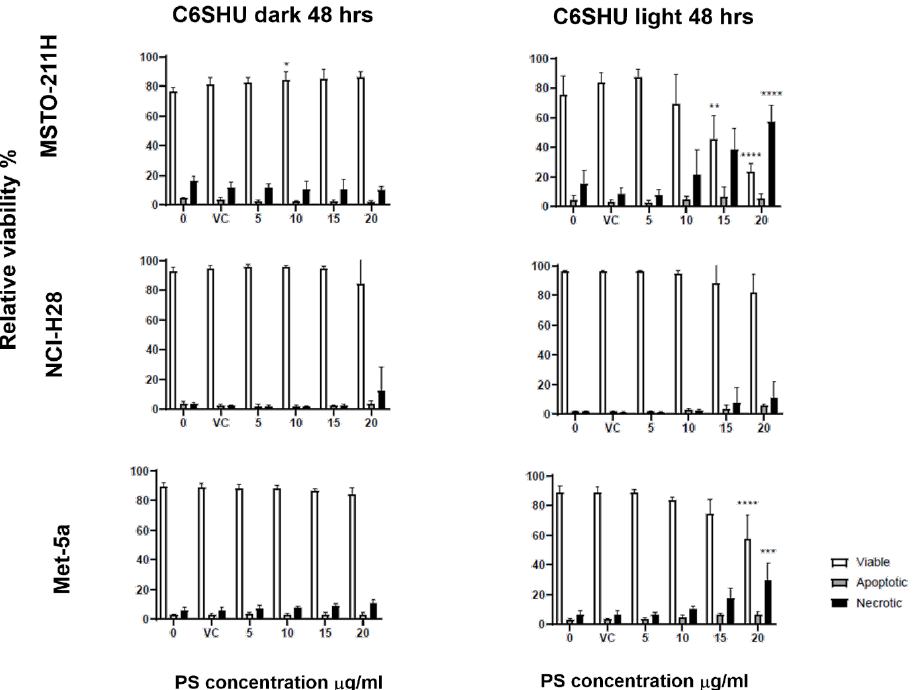
Figure 10. Cell death analysis of C6SHU-treated MSTO-211H, NCI-H28, and Met-5a cells as deter- mined by the Annexin V-FITC/PI assay 48 h after treatment. Results are expressed as the mean ± SD of three independent experiments. The varying significance of viable populations relative to that of the untreated control are indicated by * ( p ≤ 0.05), ** ( p ≤ 0.01), *** ( p ≤ 0.001), and **** ( p ≤ 0.0001).